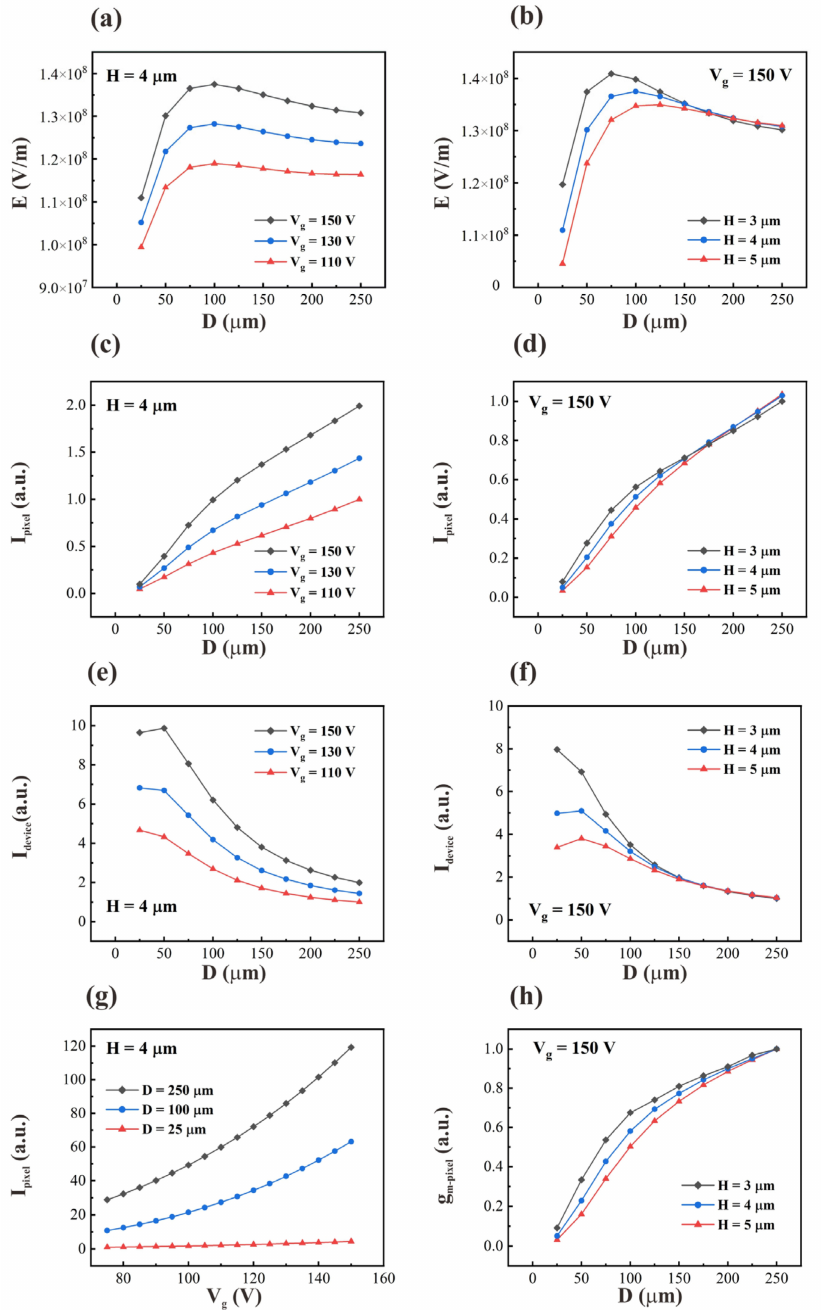
Figure 3. The simulation results of the variations of the electric field strength with pixel size for ( a ) different gate voltages (H = 4 µ m) and ( b ) different nanowire heights (Vg = 150 V); variations in one pixel current with pixel size for ( c ) different gate voltages (H = 4 µ m) and ( d ) different nanowire heights (Vg = 150 V); variations in device current with pixel size for ( e ) different gate voltages (H = 4 µ m) and ( f ) different nanowire heights (Vg = 150 V); ( g ) variations in one pixel current with gate voltages for different pixel sizes (H = 4 µ m); ( h ) variations in one pixel transconductance with pixel size for different nanowire heights (Vg = 150